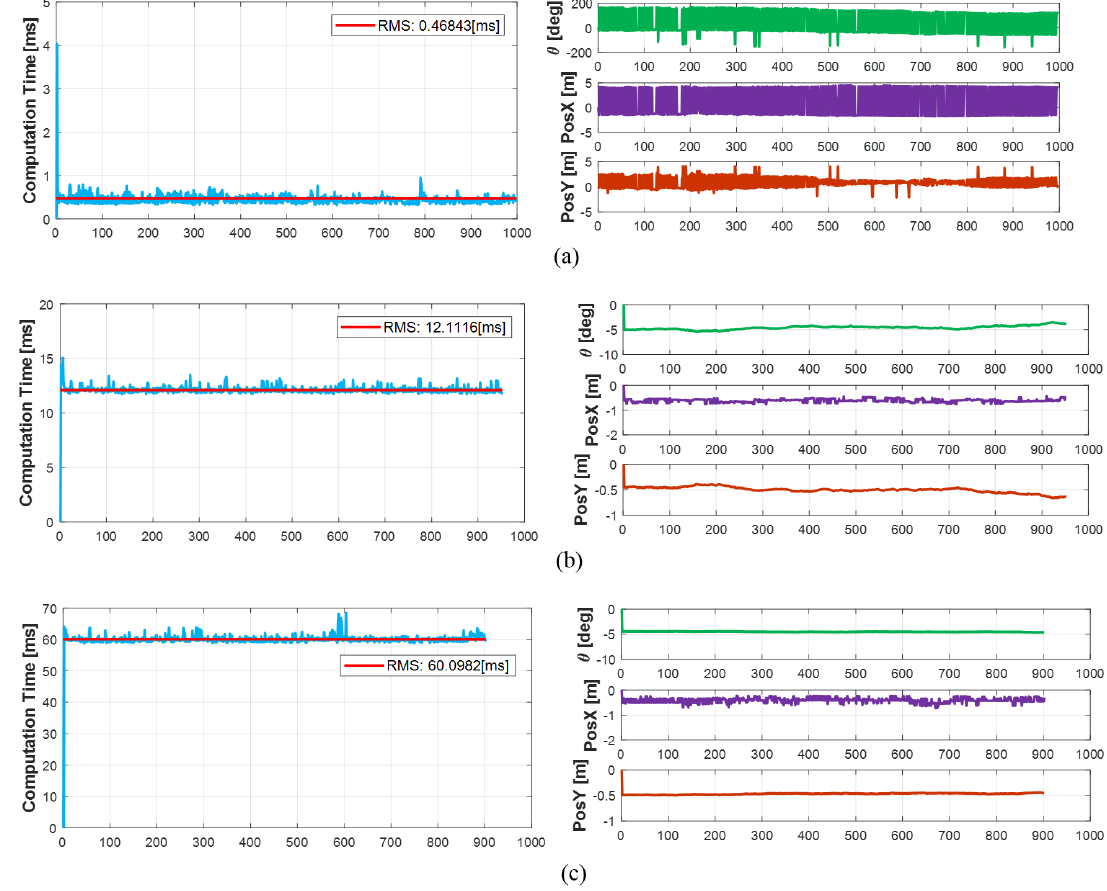
Figure 10. Characteristics of ICP with various datasets: ( a ) 4 datasets. ( b ) 50 datasets. ( c ) 100 data